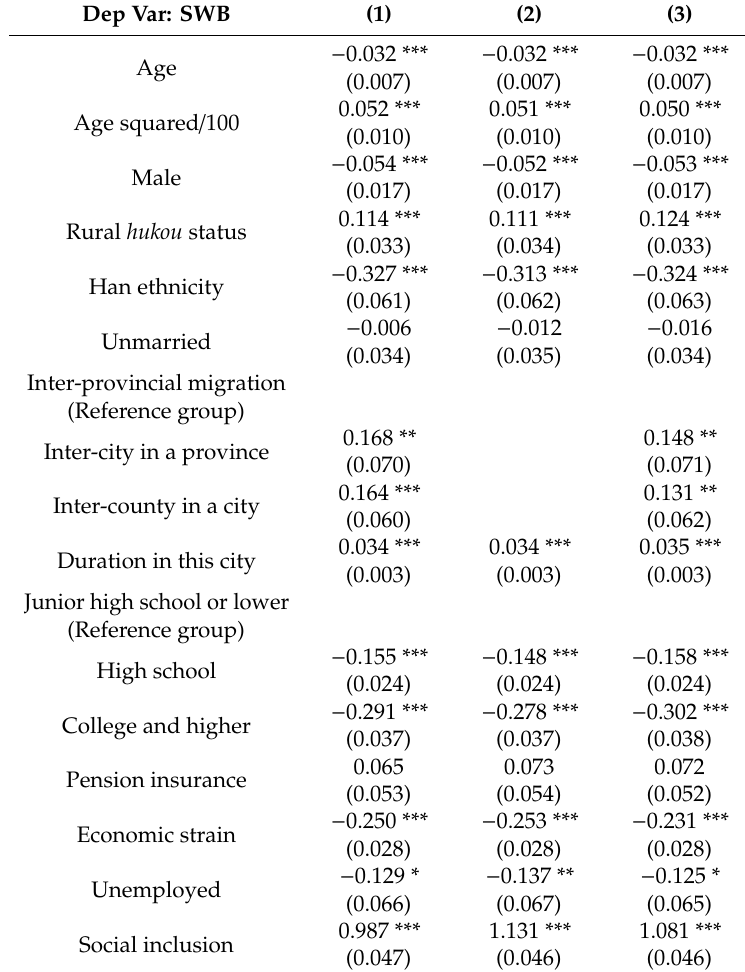
Table A6. The results of the omitted controls in Table